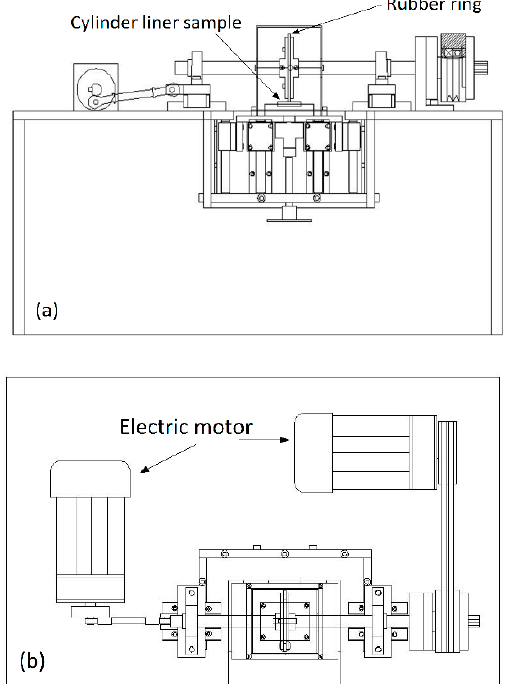
Figure 4. Diagram of mechanical honing equipment. ( a ) Front view; ( b ) vertical view.